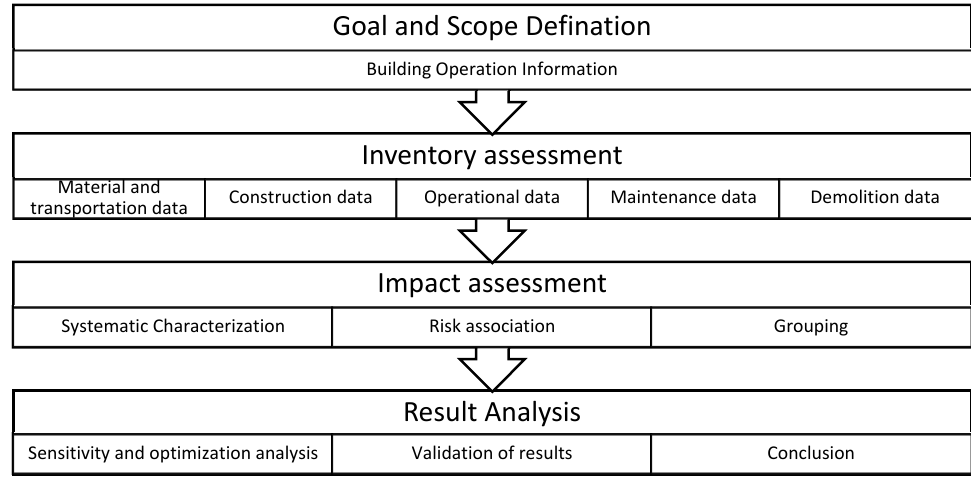
Figure 1. Critical steps in the life cycle assessment of buildings.